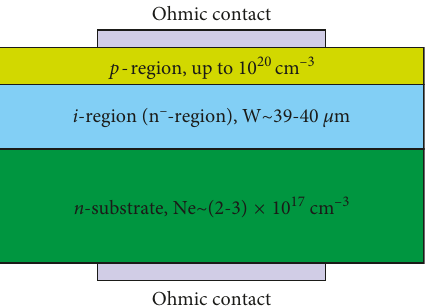
Figure 1: Schematic diode structures of p - i - n 4 H -SiC